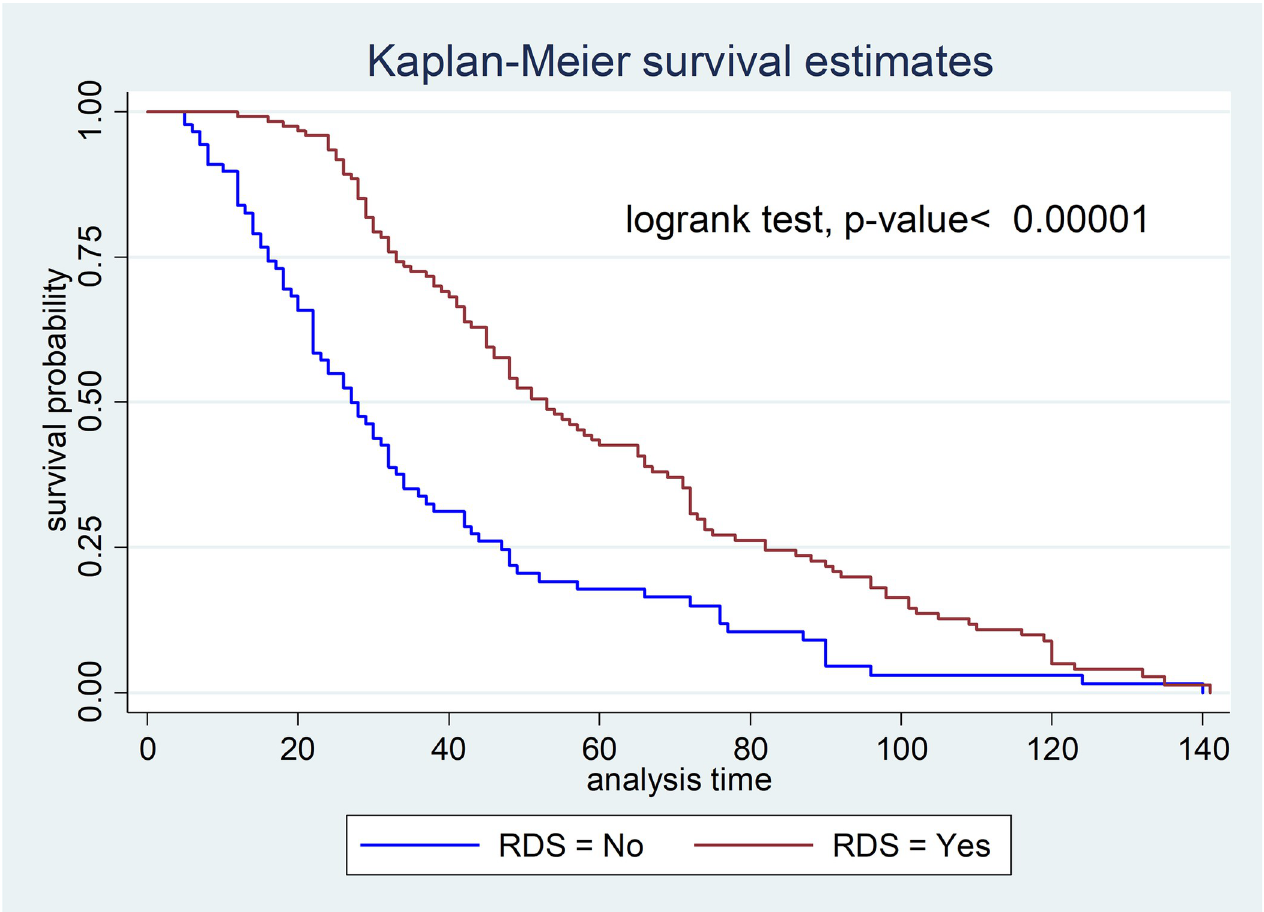
Fig 3. Kaplan-Meier survival estimate of starting TF based on respiratory distress syndrome among neonates admitted in NICU of DMCSH, FHCSH, and TGCSH, Amhara, Northwest Ethiopia from October to November/2020 (n = 210).